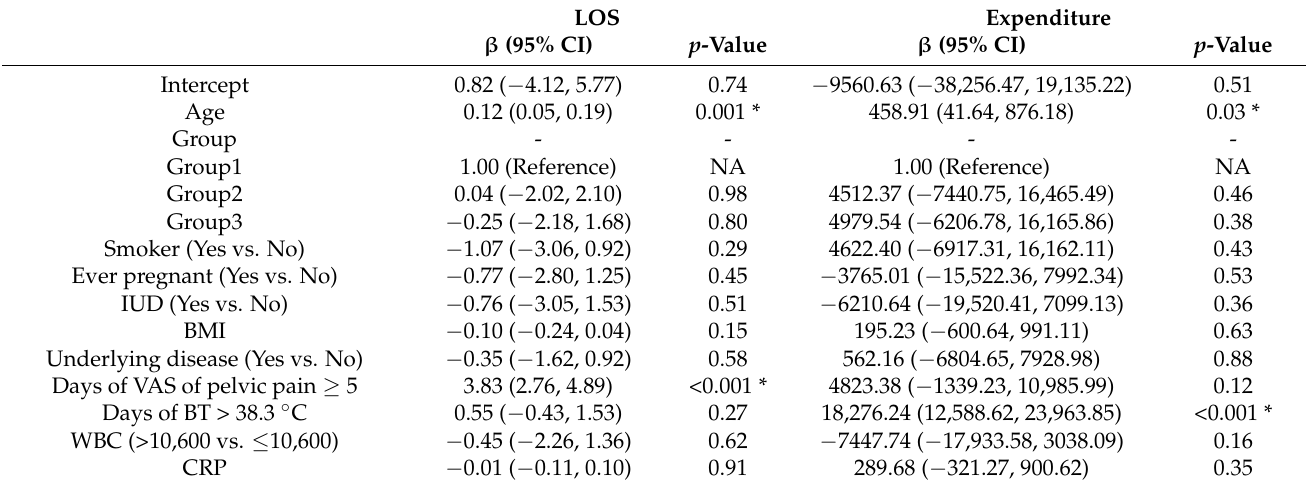
Table 3. Factors associated with secondary outcomes ( n = 107).